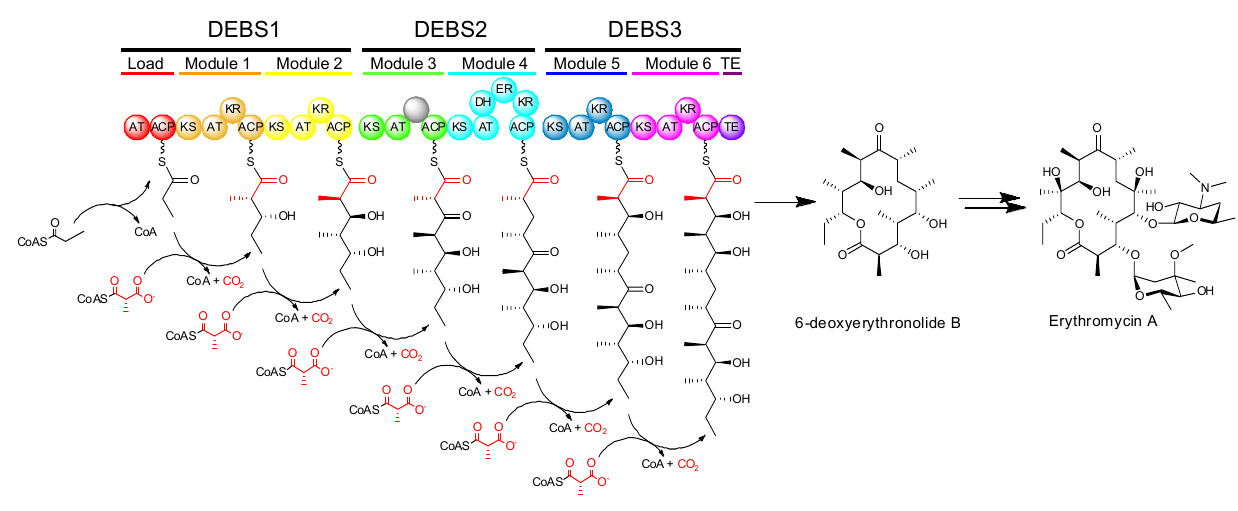
Figure 3. Biosynthesis of the aglycone of erythromycin by 6-deoxyerythronolide B synthase (DEBS) and subsequent conversion into erythromycin